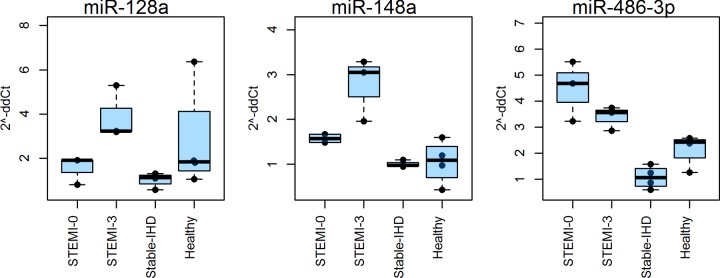
Expression profiles of miRNAsLDA-generated expression profiles of the three miRNAs chosen for further validation.